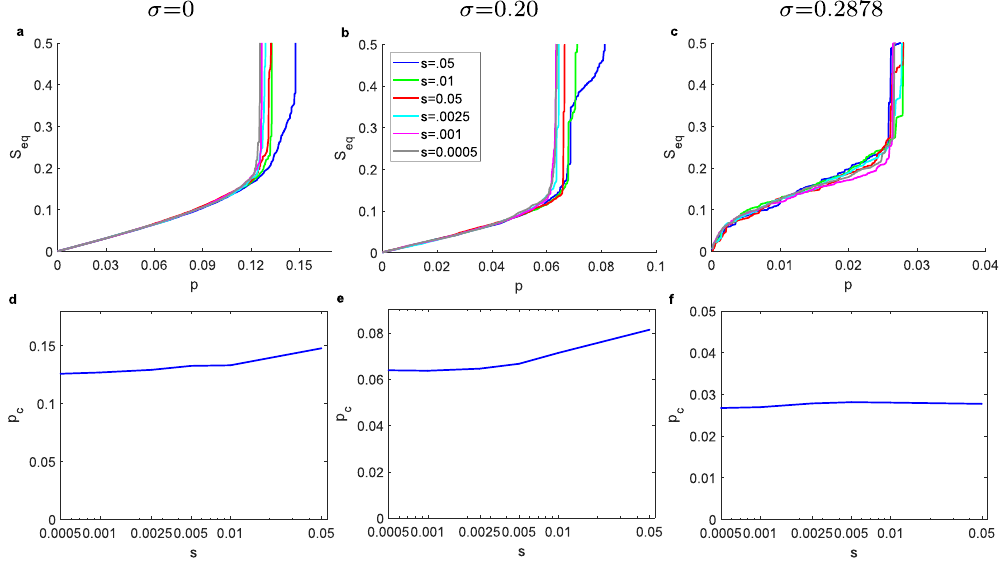
Figure 8. Impact of the size of initiator fraction s on the performance of the GPI strategy for randomizations v = 25000 for desired cascade S goal = 0.5, for ER graphs with N = 10,000, 〈 k 〉 = 10, ρ = 0. ( a – c ) Cascade S eq vs. the initiator fraction p for σ = 0, 0.2, 0.2887 respectively (for one realization). ( e – g ) Initiator fraction s required for desired cascade S goal = 0.5 vs. randomizations v for σ = 0, 0.2, 0.2887 respectively (for one